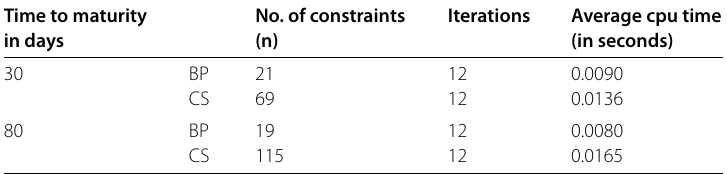
Table 1 Root mean square error (RMSE), mean absolute error (MAE), and percentage relative mean error (PRME) of the estimated call option price function (Price) and the implied volatility function (IV) with respect to mid price quotes by the proposed Bernstein polynomial method (BP) and the cubic spline smoothing method (CS) Time to maturity RMSE MAE PRME in days BP CS BP CS BP CS 30 Price 0.0610 0.0427 0.0472 0.0237 –0.6694 –1.0065 IV 0.0017 0.0016 0.0011 0.0008 –0.0632 –0.0048